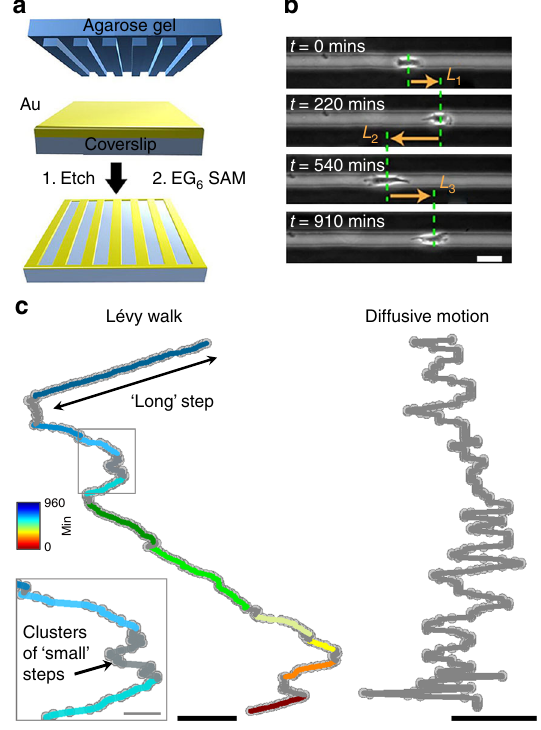
Fig. 1 Trajectories of cancer cell motions on linear microtracks. a Scheme of substrate fabrication using the Wet Etching technique 40, 48, 49 . b Optical micrographs showing a cell migrating on a microtrack (scale bar = 20 µ m).